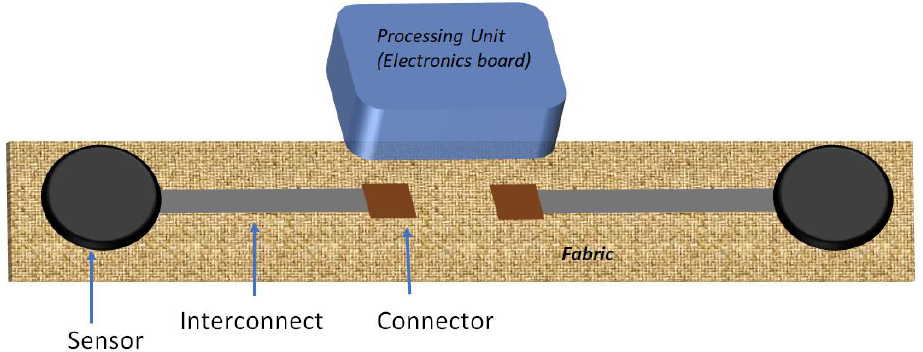
Figure 4. Interaction between textile-based and non-textile-based subsystems of a SeCS.